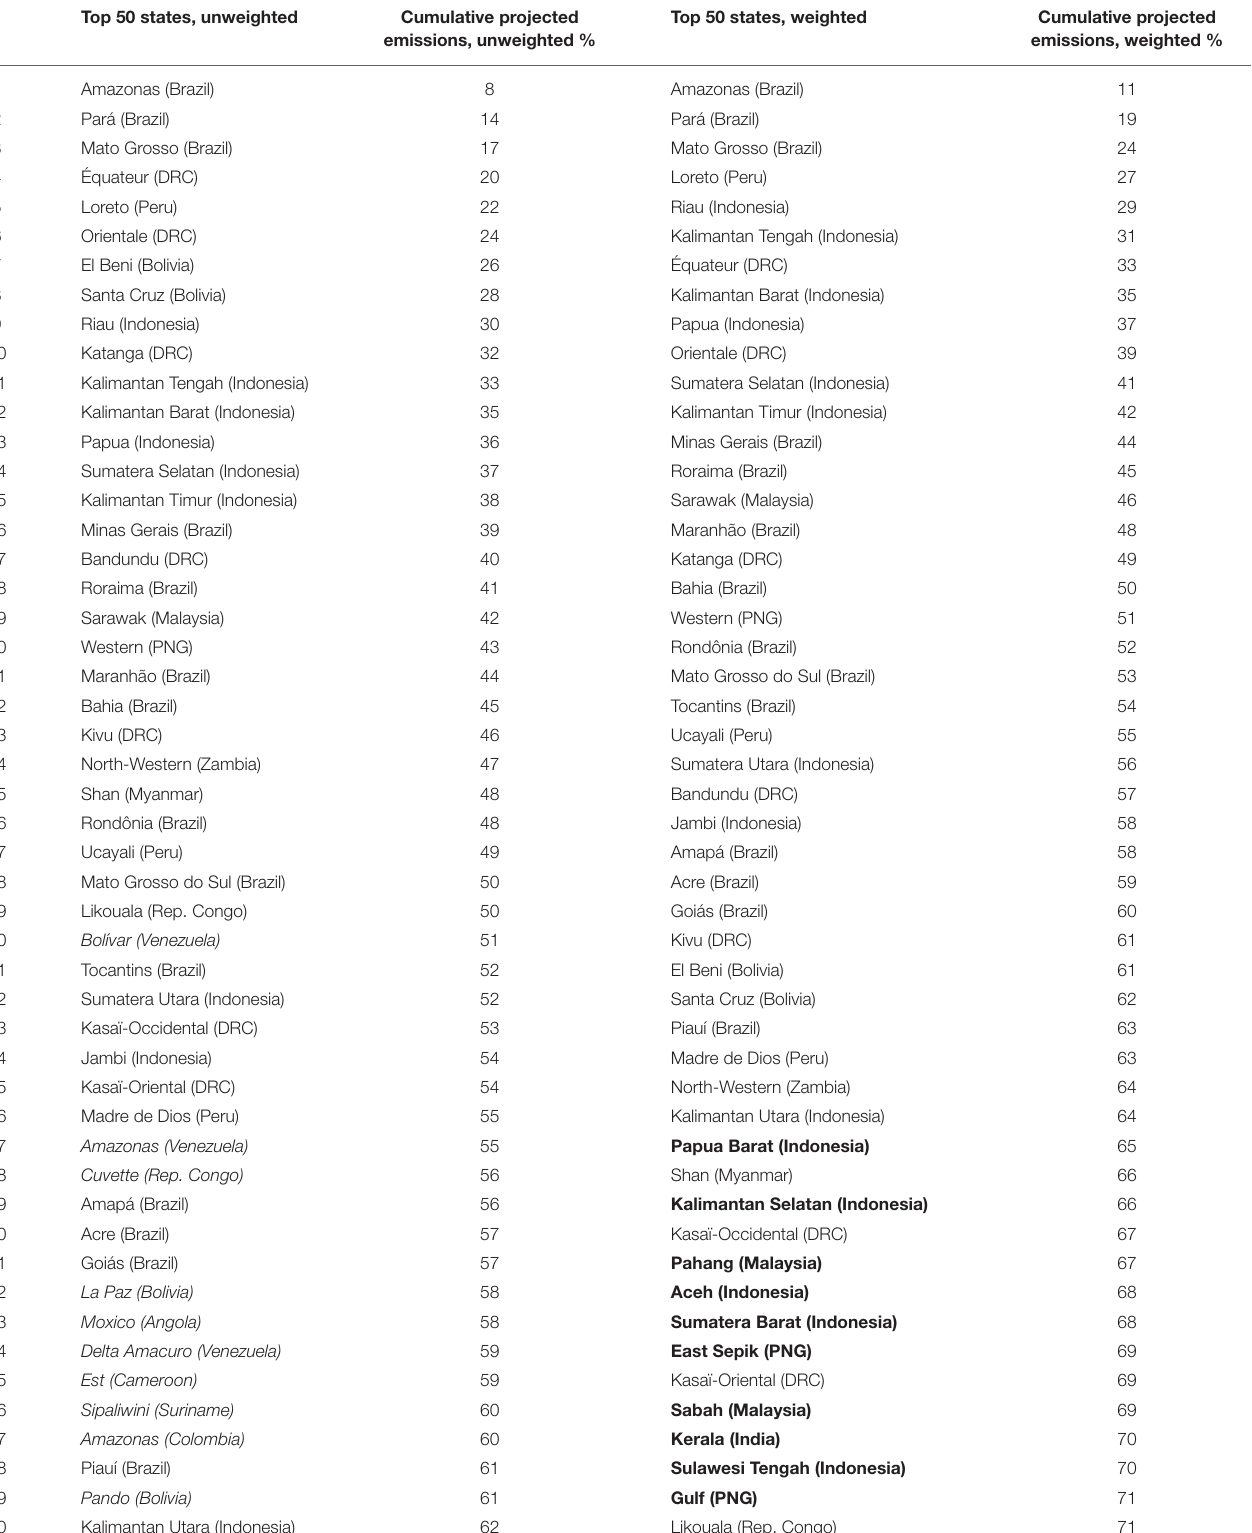
TABLE 3 | Top 50 second-tier jurisdictions by projected emissions from deforestation, unweighted vs. weighted by authority. Top 50 states, unweighted Cumulative projected Top 50 states, weighted Cumulative projected emissions, unweighted % emissions, weighted